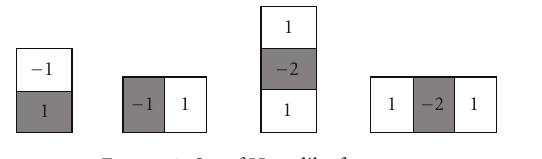
Figure 2: Set of Haar-like features.